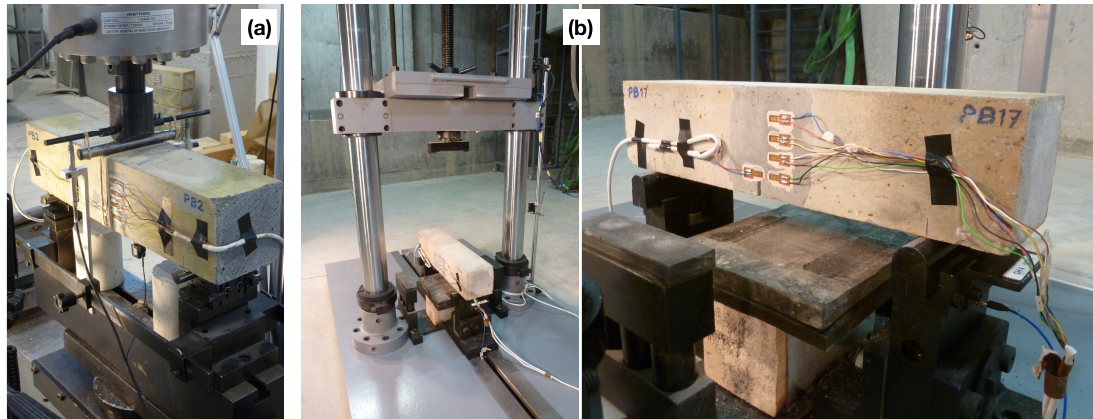
Figure 1. Beam geometry and the distribution of the glued strain gages.